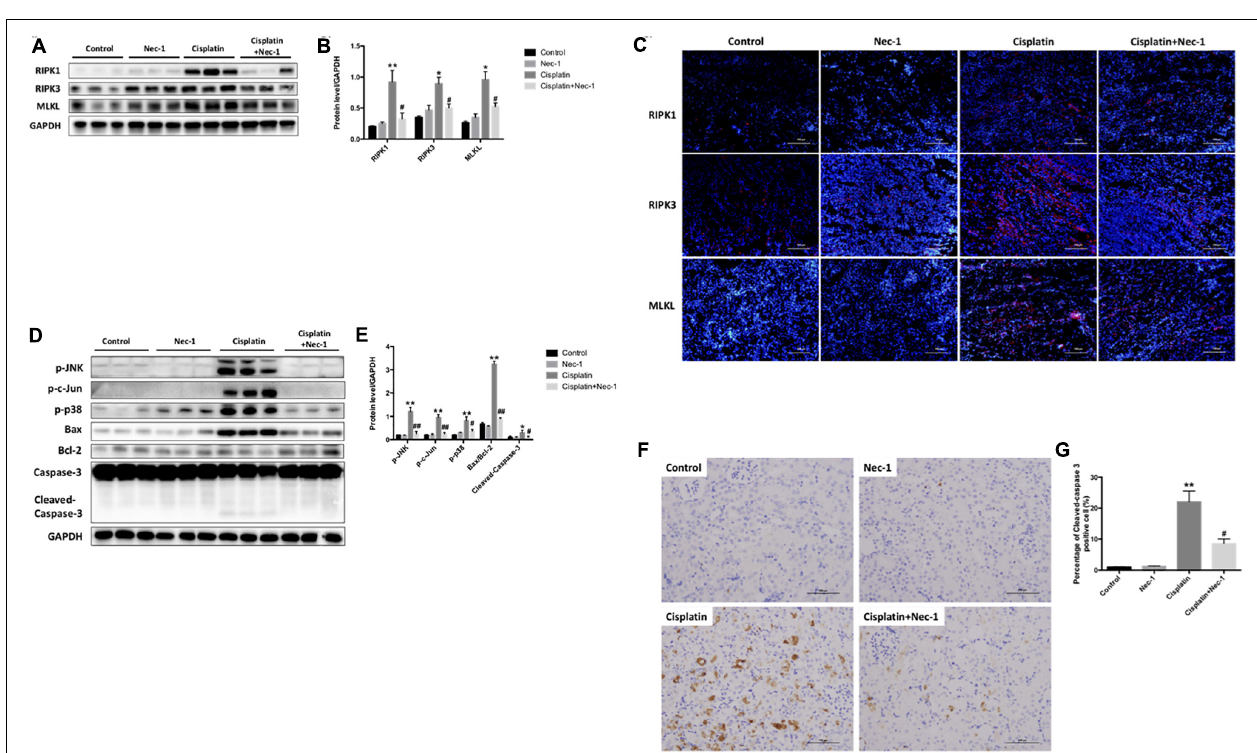
FIGURE 2 | Both necroptosis and apoptosis pathway involved in the renoprotection of Nec-1. (A,B) The protein levels of RIP1/RIP3/MLKL were all significantly increased in the kidneys of the cisplatin group compared with the control ( ∗∗ p < 0.01, ∗ p < 0.05 versus control group) and Nec-1 groups and was significantly reduced by plus Nec-1 treatment (# p < 0.05 versus cisplatin group). (C) IF staining indicated that the positive areas of RIP1/RIP3/MLKL were mainly located in tubular epithelial cells from kidneys after cisplatin administration. (D,E) The levels of stress and apoptosis-related protein, including p-JNK, p-c-Jun, p-p38, Bax/Bcl-2 ratio, and caspase-3, were significant in the kidneys at 72 h after cisplatin treatment ( ∗∗ p < 0.01, ∗ p < 0.05 versus control group). However, these effects were eliminated in different level after Nec-1 administration (## p < 0.01, # p < 0.05 versus cisplatin group). (F,G) IHC staining of cleaved caspase-3 showed the same tendency among the four groups ( ∗∗ p < 0.01 versus control group, # p < 0.05 versus cisplatin group).